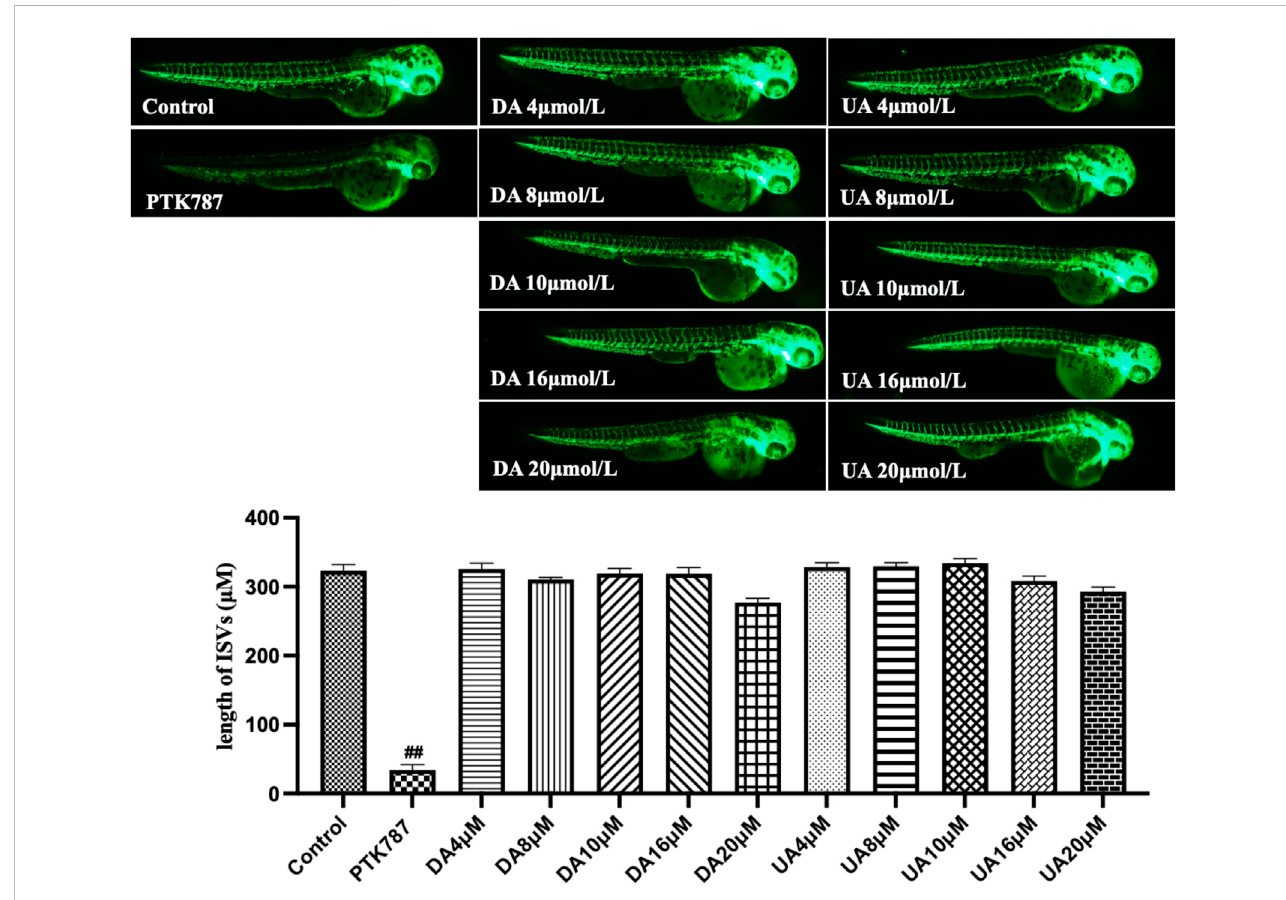
FIGURE 7 Lack of anti-angiogenic effects of deoxycholic acid (DA) and ursodeoxycholic acid (UA) in a zebra fi sh model. Lateral view of zebra fi sh embryos treated with DMSO (0.1%, Control), PTK787 (0.2 μ g/mL), two bile acids added for 24 h. At 16 μ M of each bile acids, some deformity was apparent, with the degree of malformation (yolk sac edema, tail malformation) increased at 20 μ M. Compared with the Control group, these two bile acids had no effects on angiogenesis in the ISVs. In contrast, PTK787 effectively inhibited the growth of the ISVs. Statistical analysis data were shown as mean ± SEM (n ≥ 8). The comparison between groups was performed by student ’ s test. ## p < 0.01 versus Control